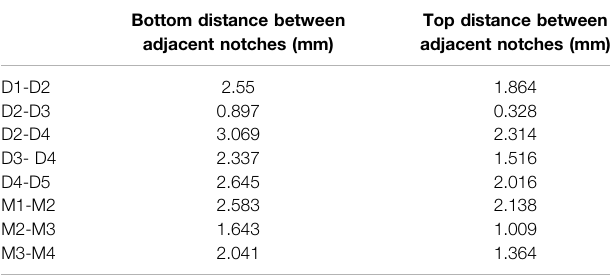
TABLE 2 | Distance between the adjacent notches incised on the QG10 perforated red deer tooth. Bottom distance between adjacent notches (mm)